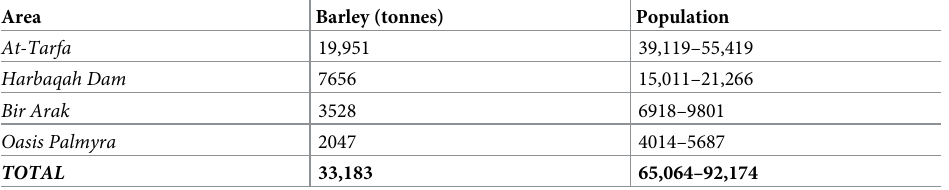
Table 1. Estimates of the maximum possible population fed in optimal